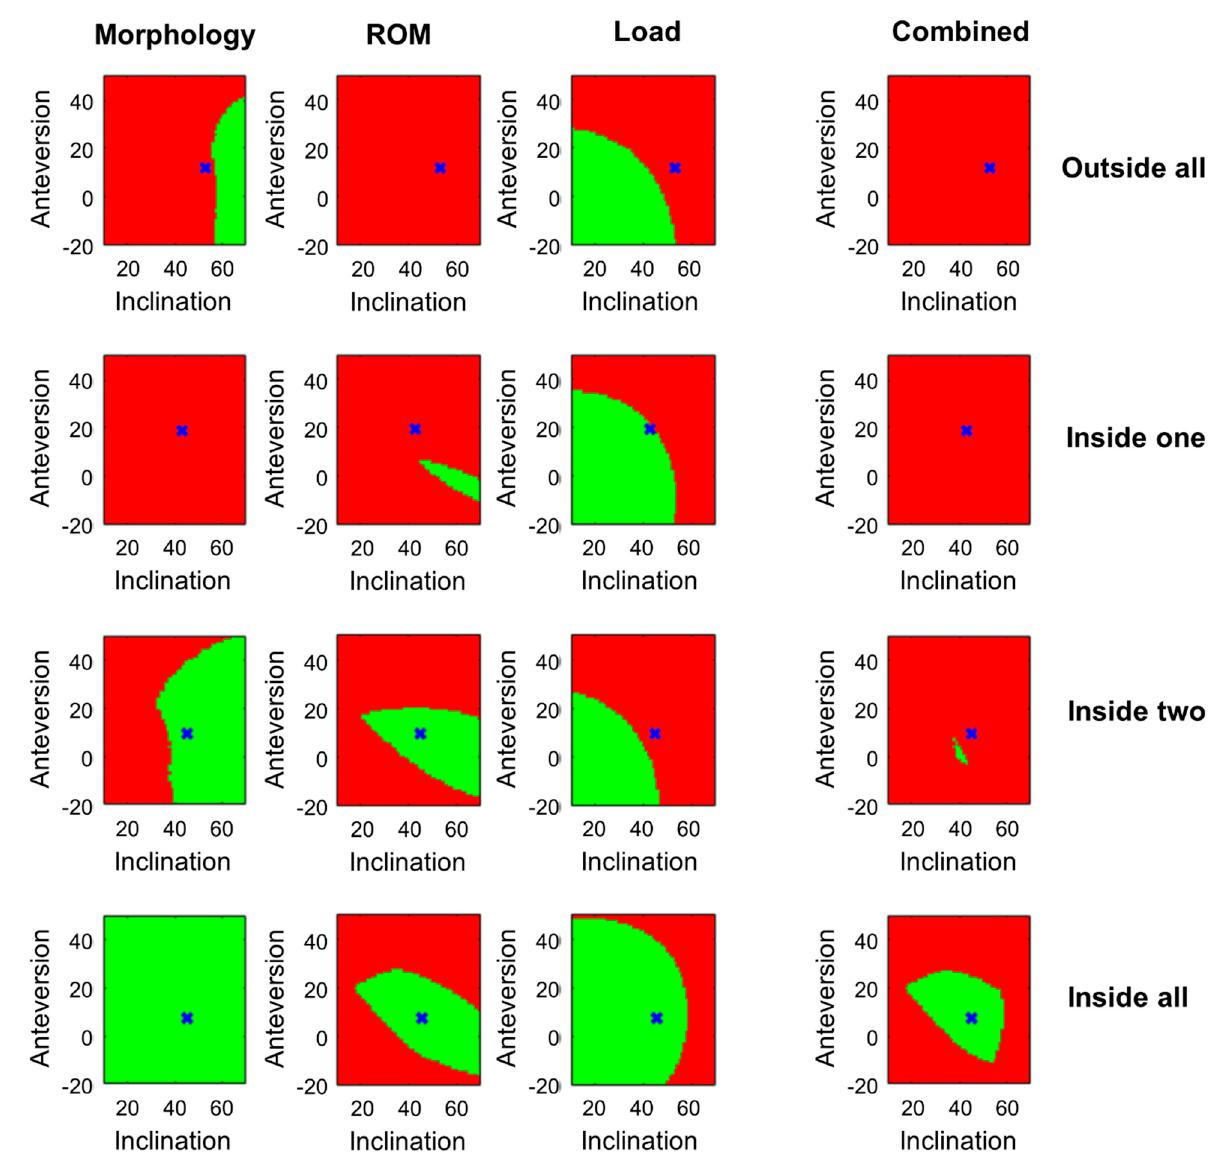
Figure 7. Patient-specific morphology-based, ROM-based, load-based and combined target zone for four exemplary cases. The target zones for the implant and implantation parameters based on the postoperative CT data is shown. The blue x marks the measured postoperative cup orientation.